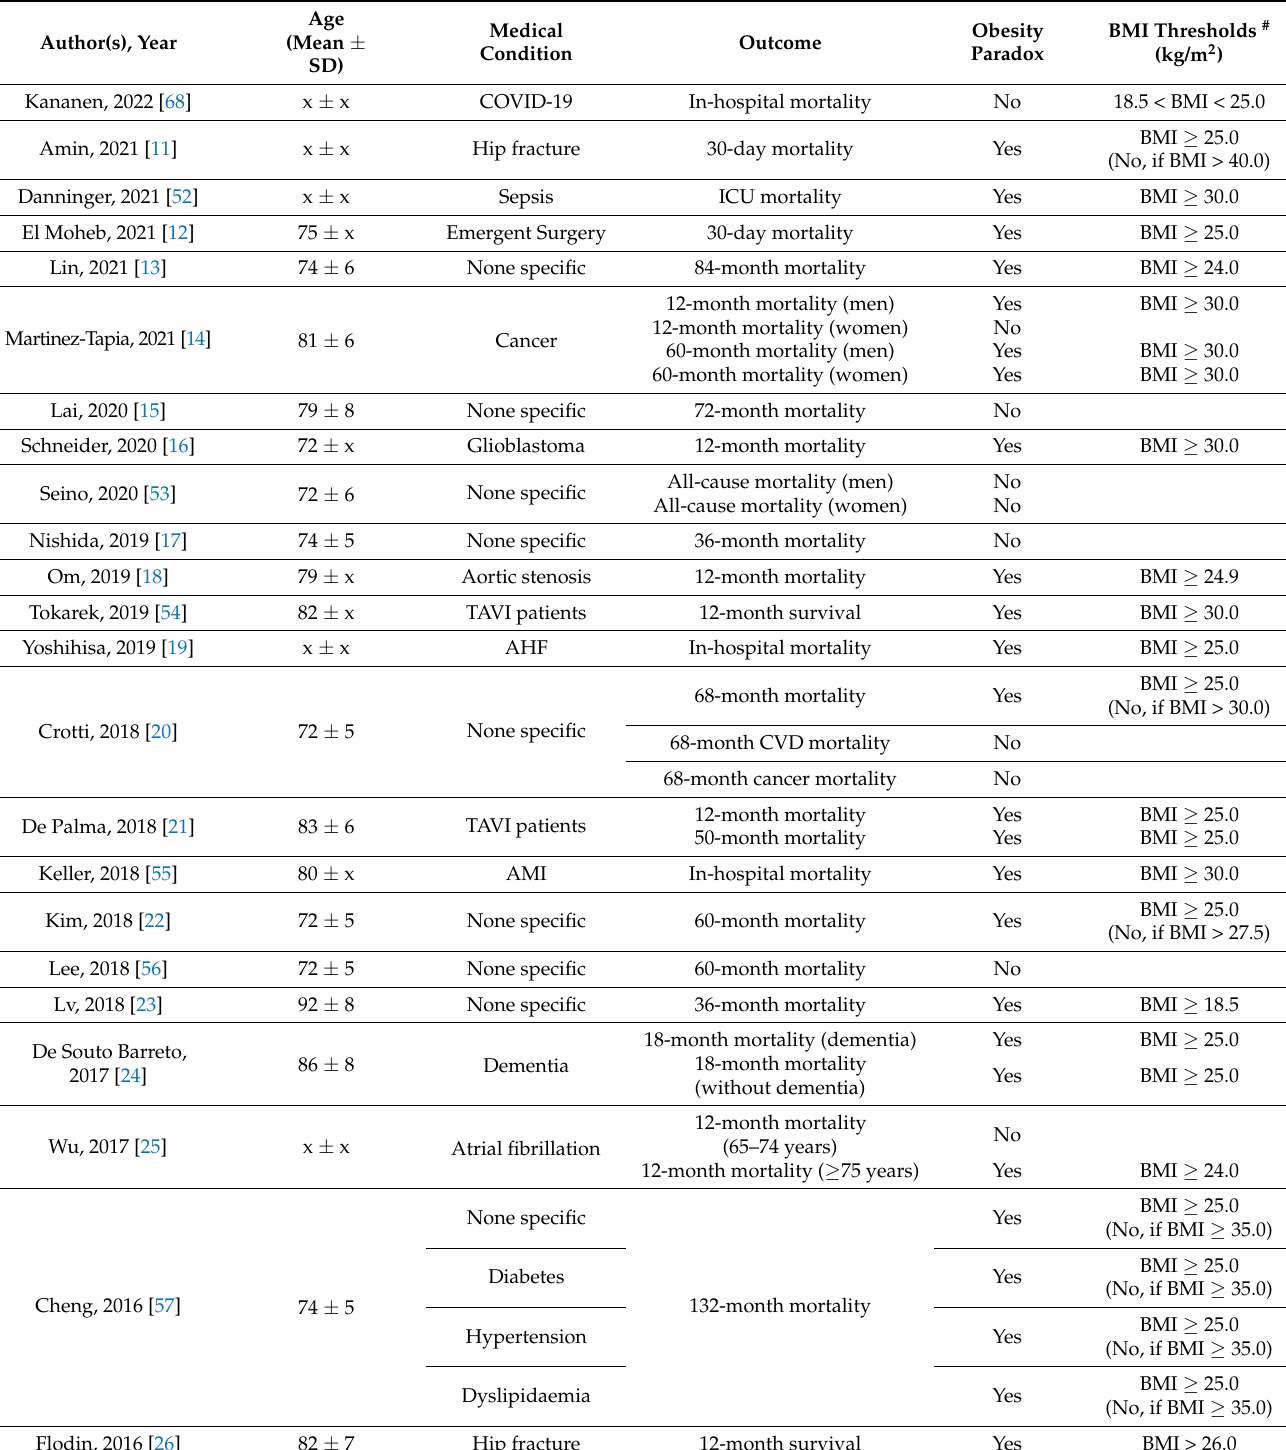
Table 2. Outcomes and association between body mass index group and mortality in aged